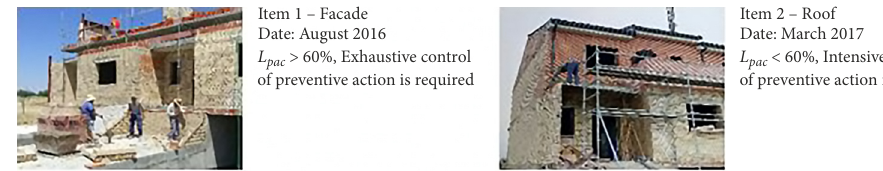
Figure 4. Images of the construction development of the